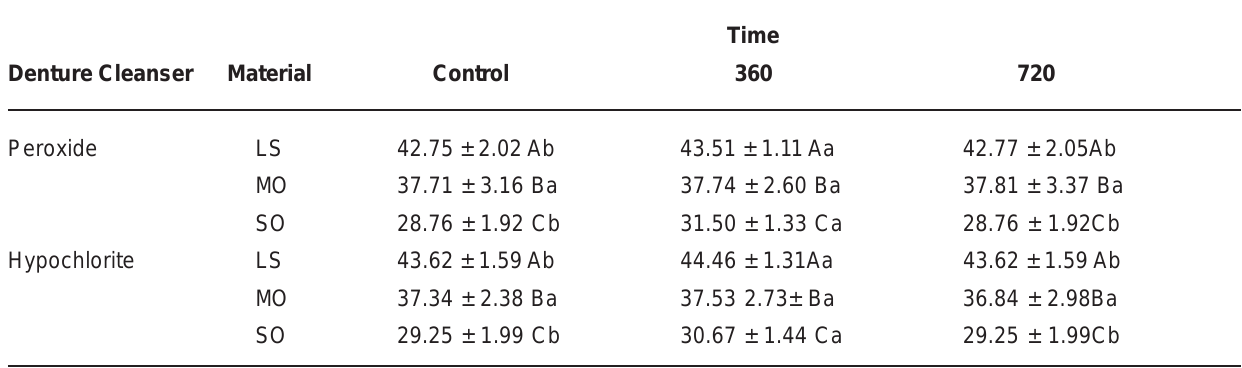
Means followed by the same upper case letter in a column (time and treatment) and the same lower case letter in a row (material and treatment) do not differ statistically by Tukey at a 5% probability level. (p =